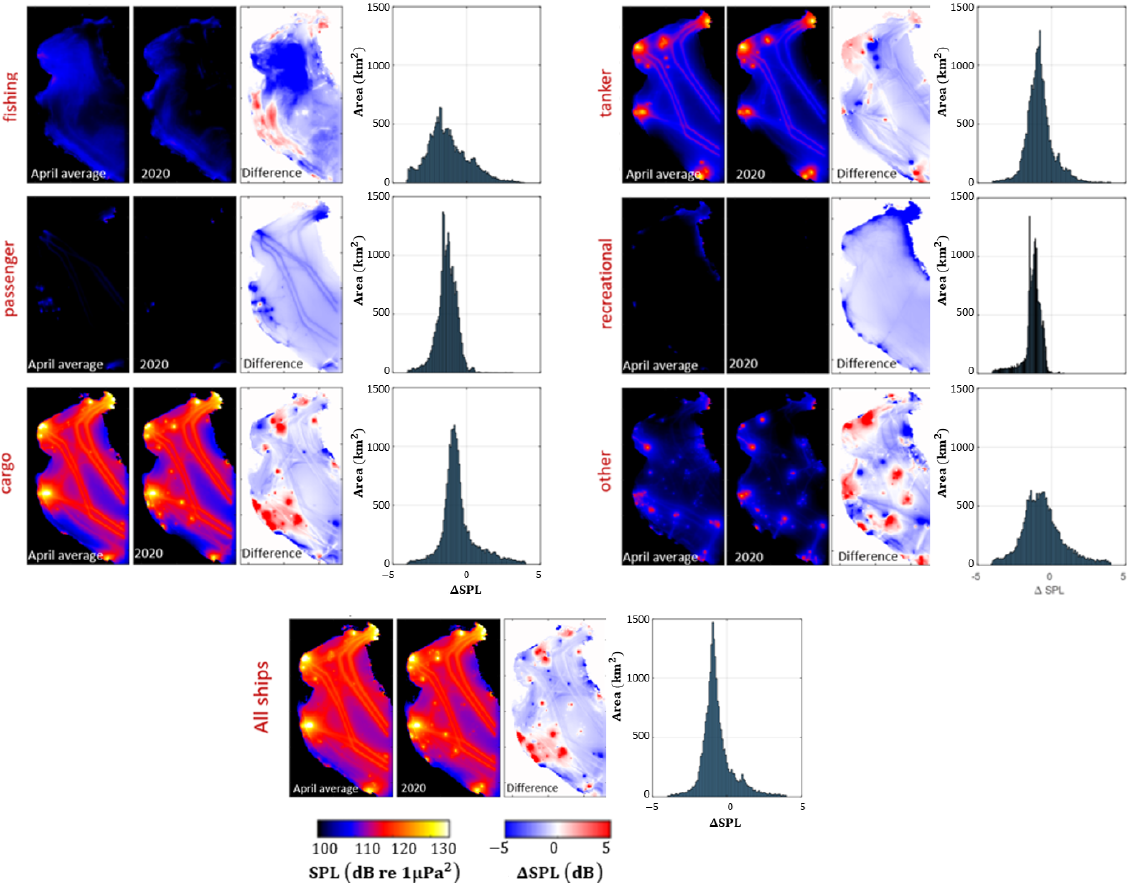
Figure 13. Comparisons for the sound maps of April Average and April 2020 for 100 Hz to 10 kHz in test area 2. The histograms show the amount of the difference in SPL per km 2 for test area